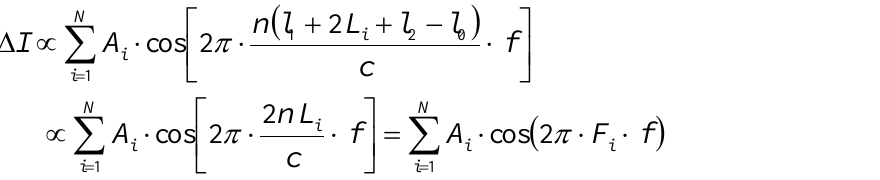
sensor multiplexing. LS: light source; CIR: circulator; BD: balanced detector; AOM: acousto-optic modulator; PC: polarization controller; C couplers; S : i th sensor (of reflection i